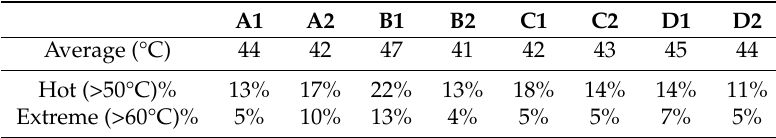
Table 7. Temperature monitoring of candidate